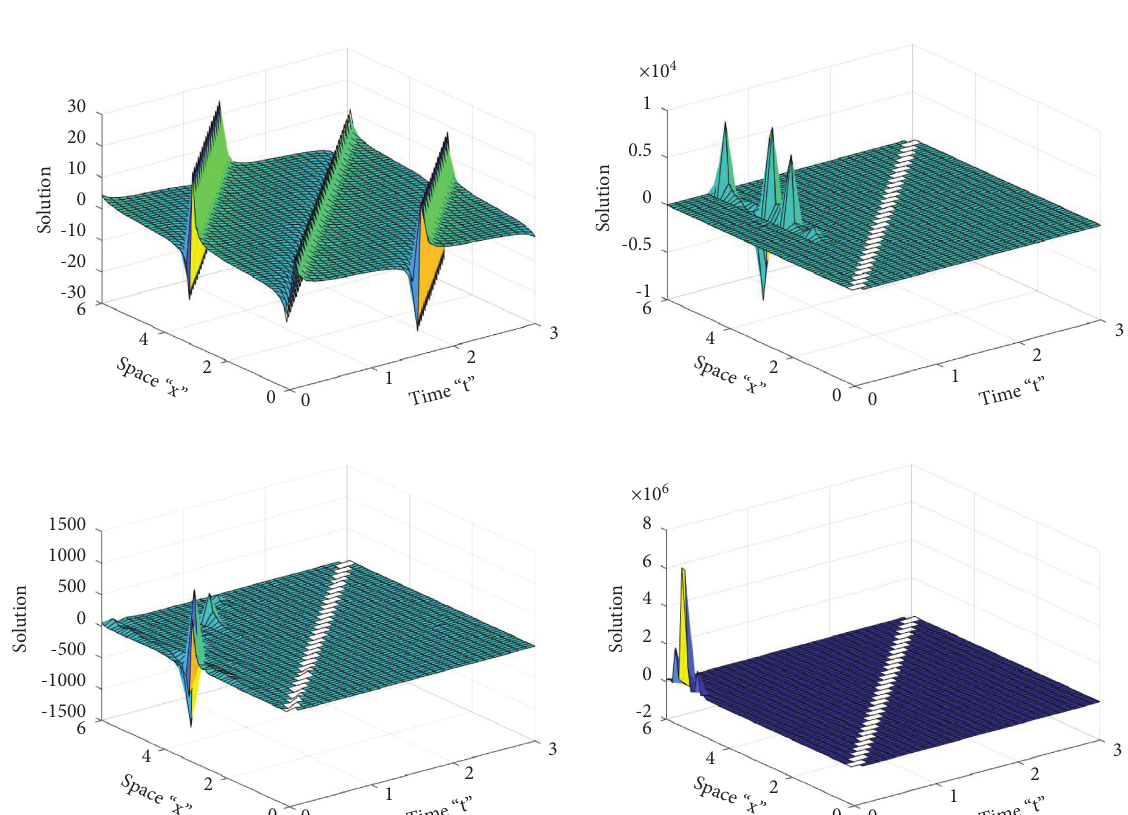
Figure 3: The solution w in equation (30) with α �